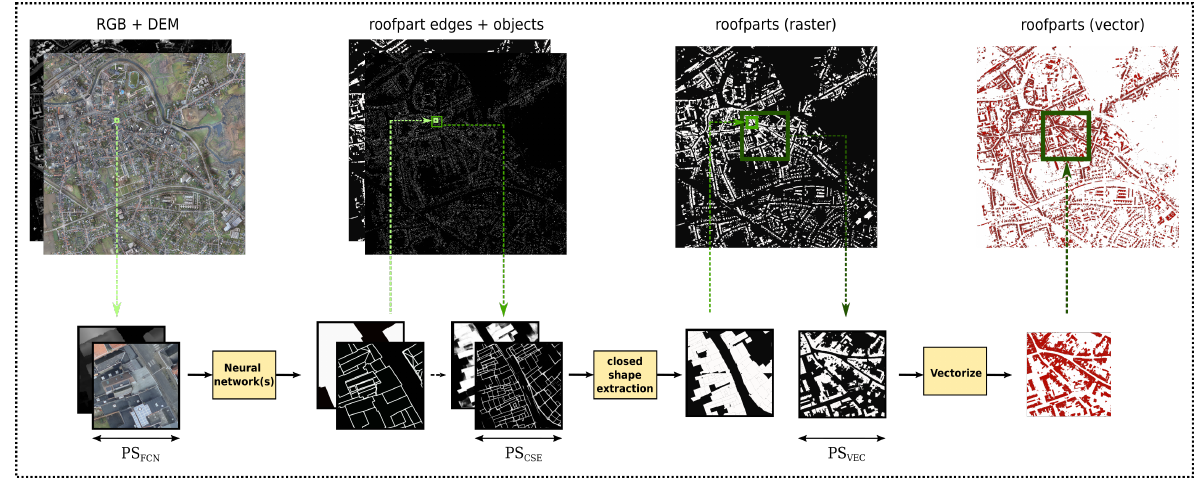
Figure 4. Schematic workflow overview for large scale roof-part polygon extraction from optical (RGB) and height/depth (D) orthoimagery. The workflow consists of three main steps: ( 1 ) a fully convolutional neural network (FCN) model is used to predict semantic roof edges and objects. ( 2 ) Distinct closed shapes are extracted given the roof edges and objects. ( 3 ) The closed shapes are vectorized to obtain roof-part polygons. Each step is computationally constrained by a certain patch size (PS), where usually PS FCN < PS CSE < PS VEC . As a larger PS corresponds to a smoother global prediction, intermediate results can be saved to allow for the three PSs to be